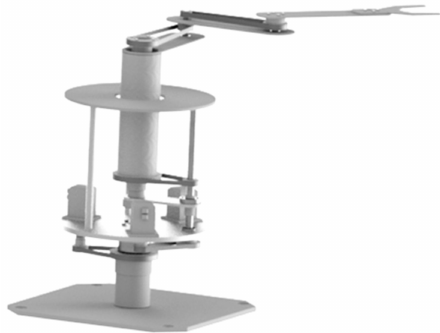
Figure 11. Overall design of the stretching pose for the open handling